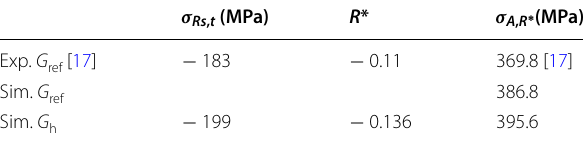
Table 4 Calculated stress amplitudes and load ratios for both variants G and G ref